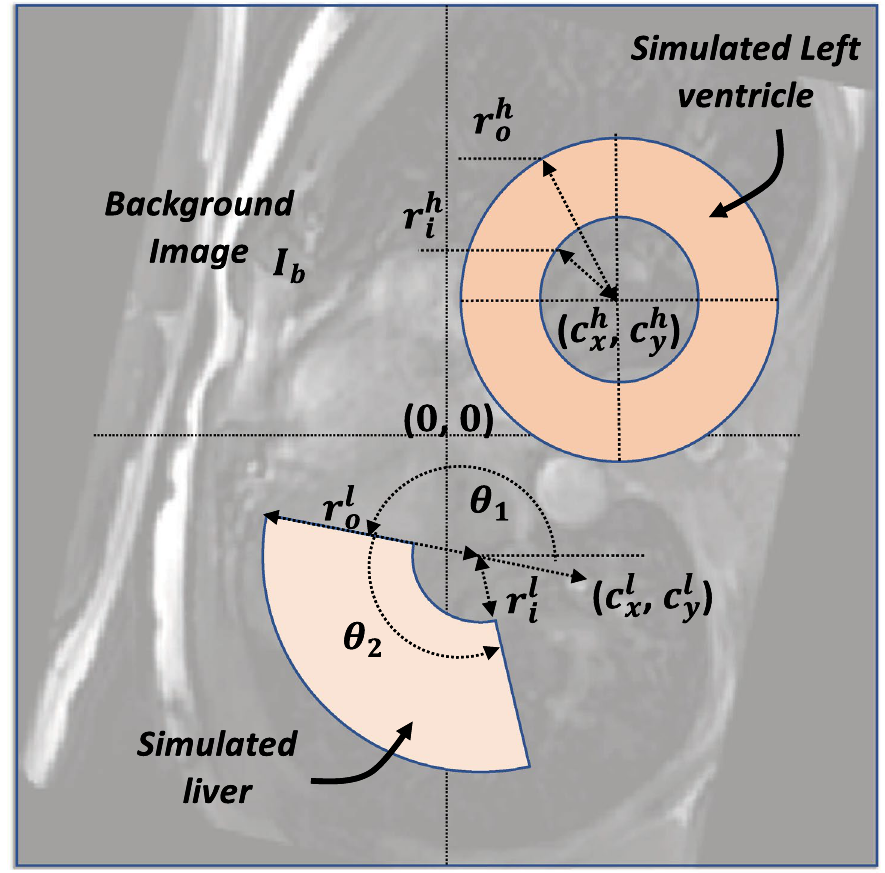
Figure 11. A schematic representation of the components of a simulated image. A background image I b represents the anatomical image. The simulated left ventricle and liver shapes are created based on their geomatical parameters, with values chosen randomly from their corresponding